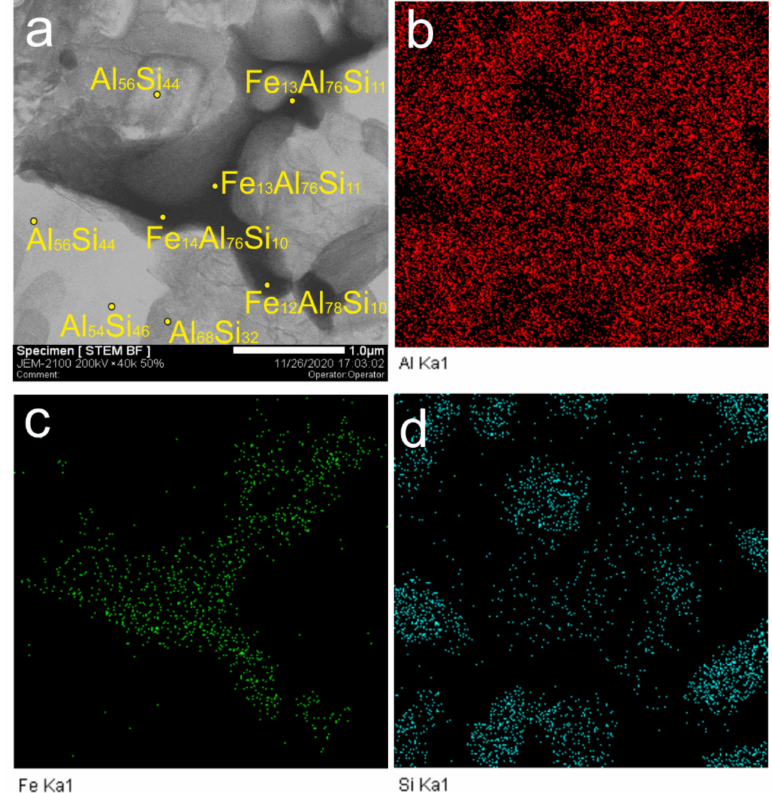
Figure 12. Iron-rich particles ( a – c ) and silicon-rich ( a , d )